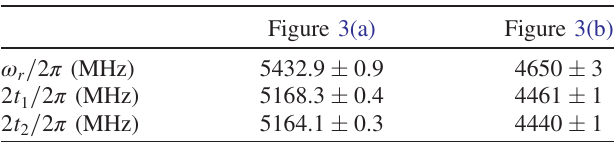
TABLE IV. Extracted values from the fits performed on the data presented in Fig. 3(a) with taking the coupling rates obtained from the fits in Fig. 2. For Fig. 3(b), the coupling rates are extracted from the data in Fig. 8. In the caption of Fig. 3, we quote the Lamb-shifted qubit transitions as they are here in the table directly extracted from the Hamiltonian fit.